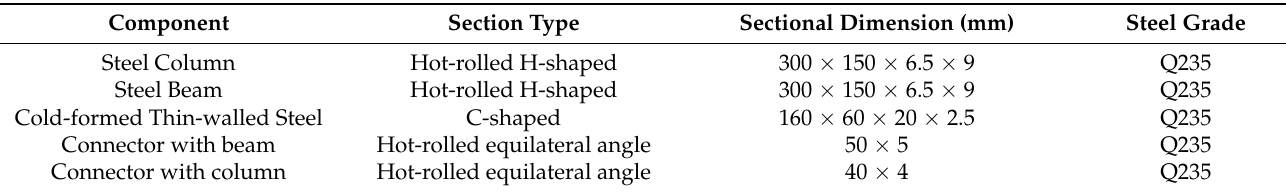
Table 1. Parameters of the component.